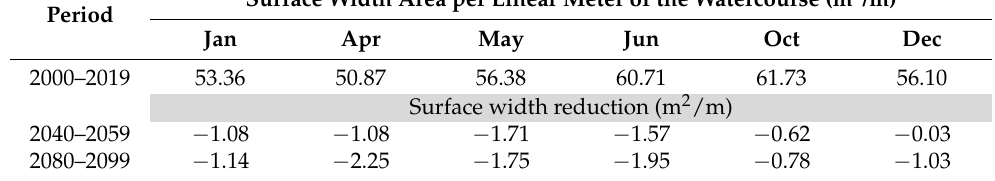
Table 6. Reduction in the surface